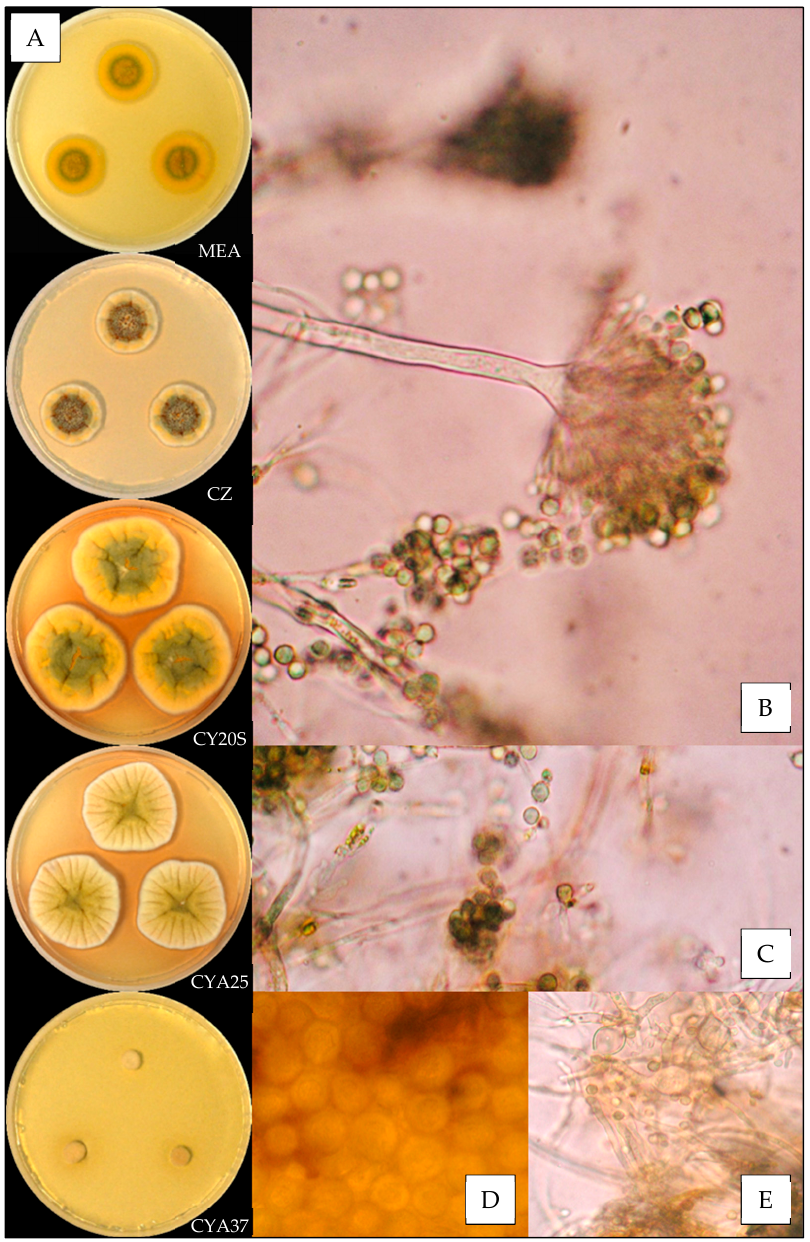
Figure 5. Aspergillus jensenii: ( A ) from top to bottom, colonies on MEA, CZ, CY20S, CYA25 and CYA37, 14 days. ( B ) Conidial head, ( C ) conidia, ( D ) globose Hülle cells and ( E ) chlamydospores (1000×).